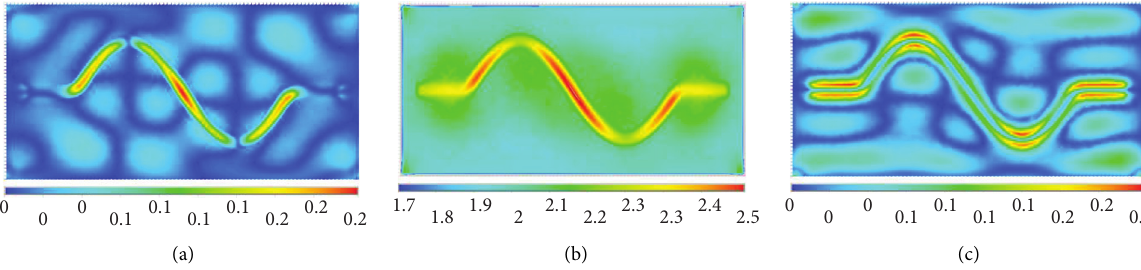
Figure 35: SH wave incident ( H � 100m, f � 1.0Hz, C